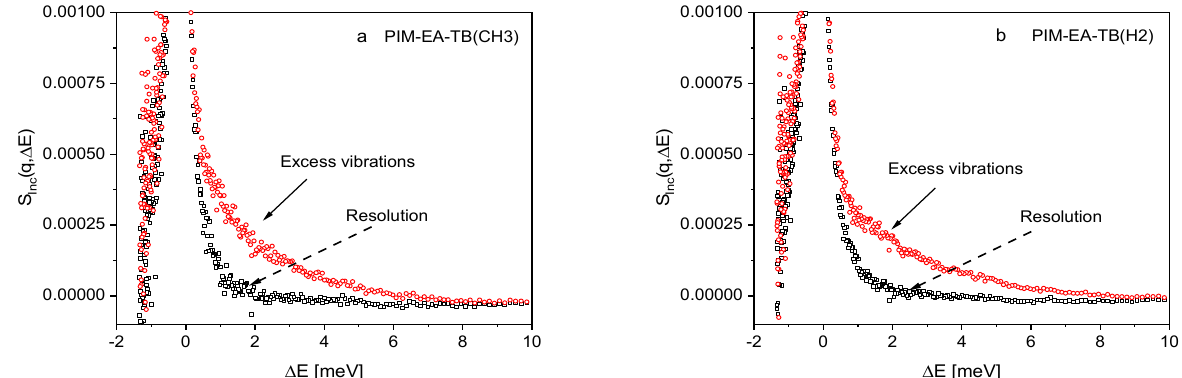
Figure 2. S inc (q, ∆ E) normalized by the maximum of the elastic line measured for ( a ) PIM-EA-TB(CH 3 ) and ( b ) PIM-EA- TB(H 2 ) at DCS at 50 K compared to the spectrometer obtained by measuring the sample at 4 K. The data were averaged over all angles.